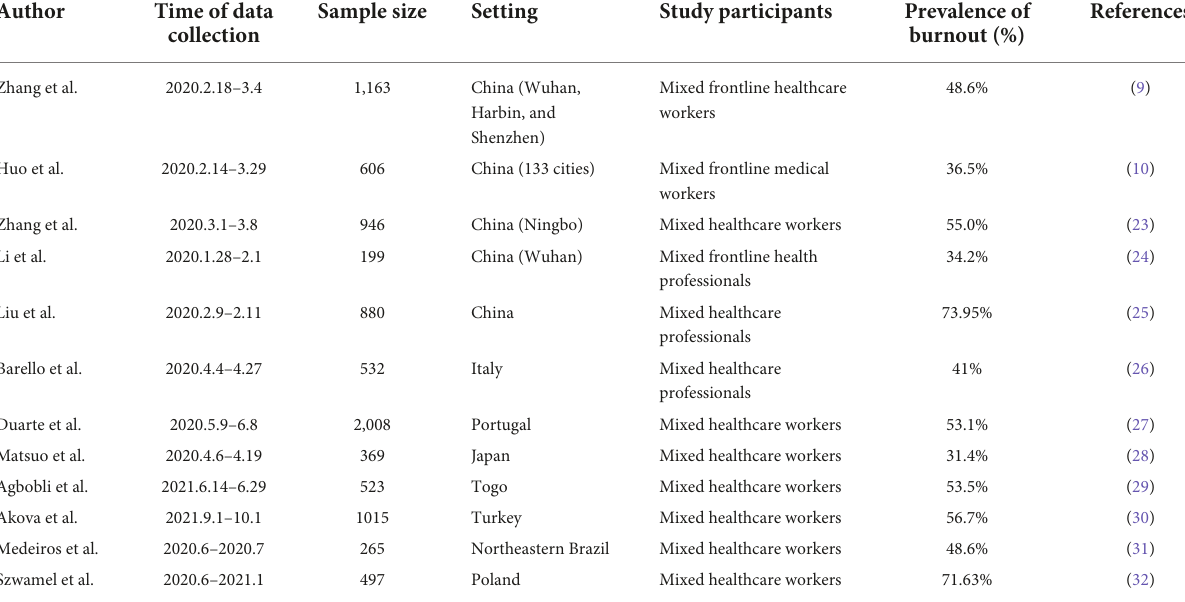
TABLE 3 The estimates of burnout among healthcare workers during COVID-19 pandemic from different cross-sectional